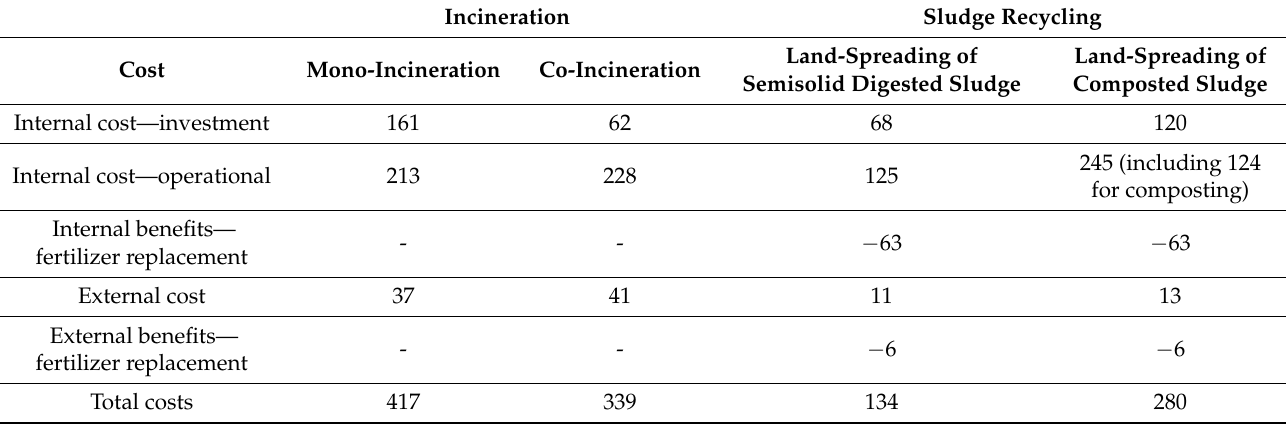
Table 4. Net cost of sludge incineration and sludge recycling ( € /tDS), adopted from [57], with